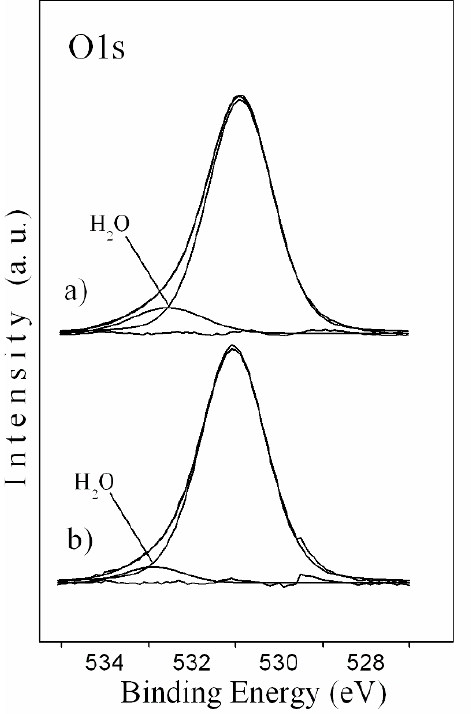
Figure 4. Binding energy of Zr3d peaks of: a) ZrMo